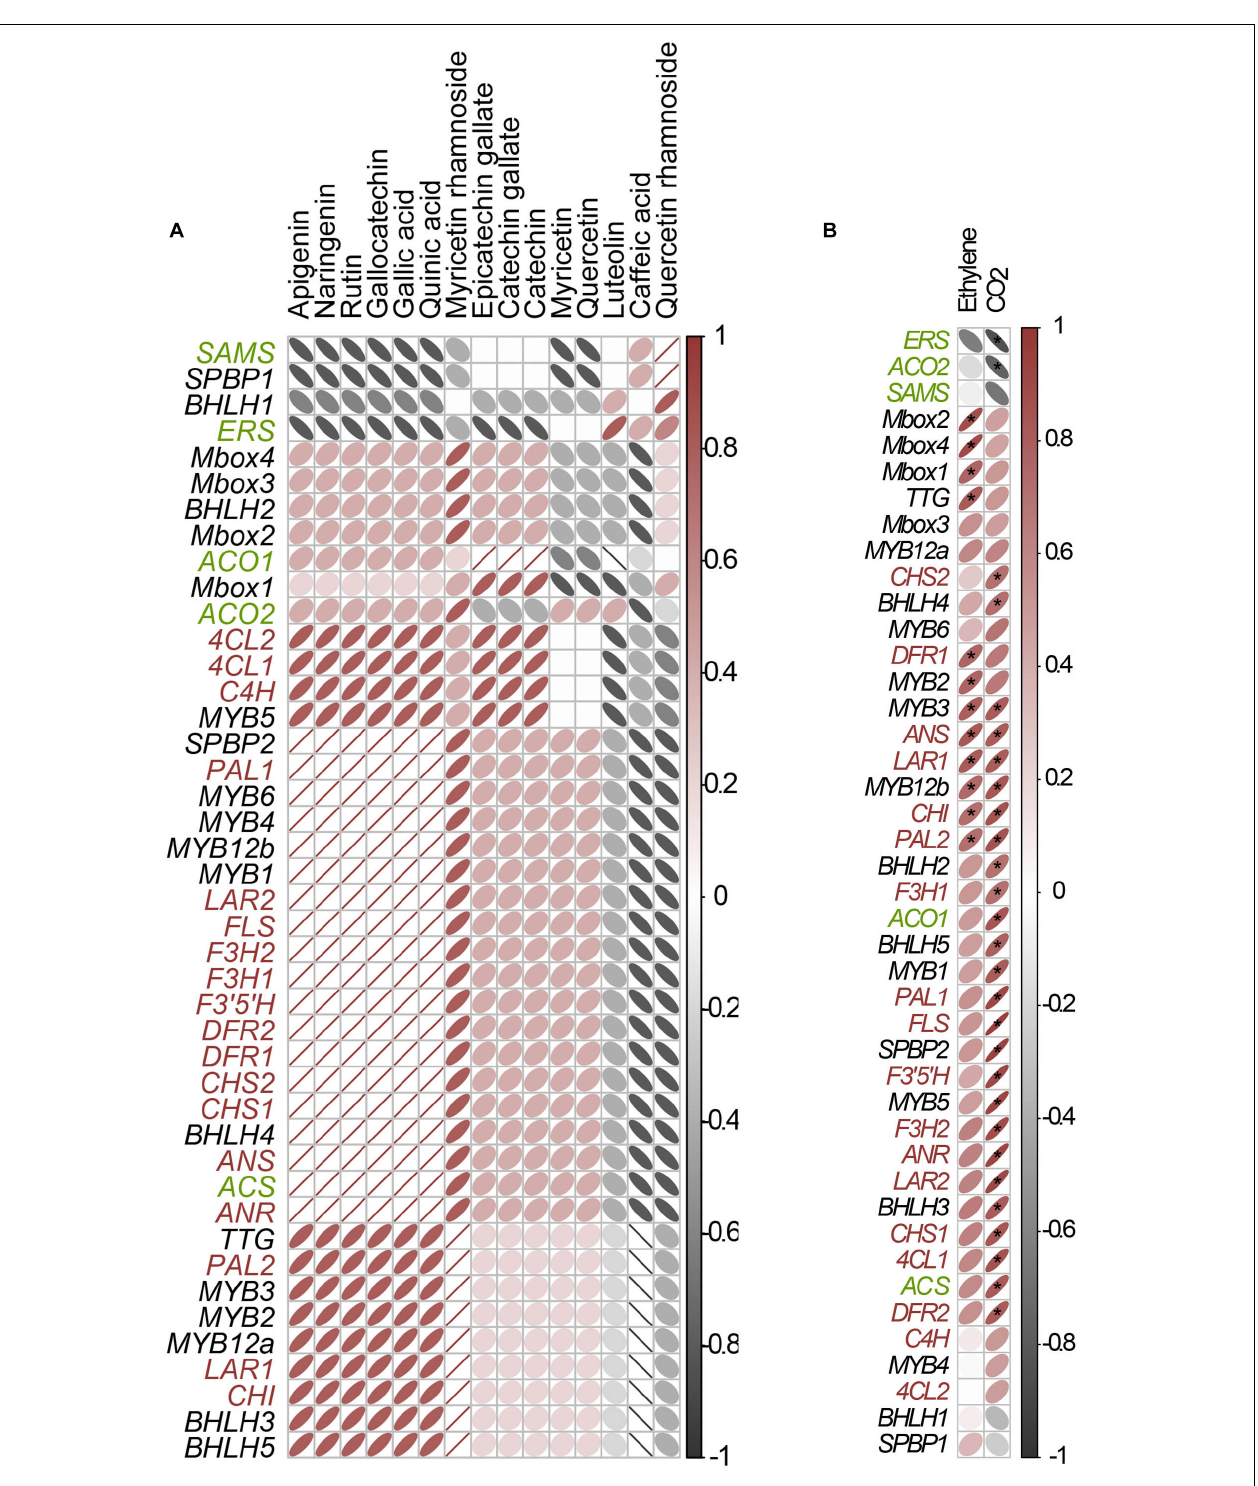
FIGURE 7 | (A) Pairwise correlation analysis of gene expression and phenolics quantitative data in flowers (S0) and fruits of three developmental stages (S0–S3). Since different biological samples were used for metabolomics and expression measurements, the correlation was performed on averaged data by developmental stage. (B) Pairwise correlation analysis of gene expression and ethylene production and respiration (CO 2 ) data in Cistus fruits of three developmental stages (S1–S3). For both (A,B) , the correlation matrix was constructed using Spearman (rank) correlations between compound quantity and relative gene expression. Asterisks denote significant ( p < 0.05) association between paired samples using a two-sided